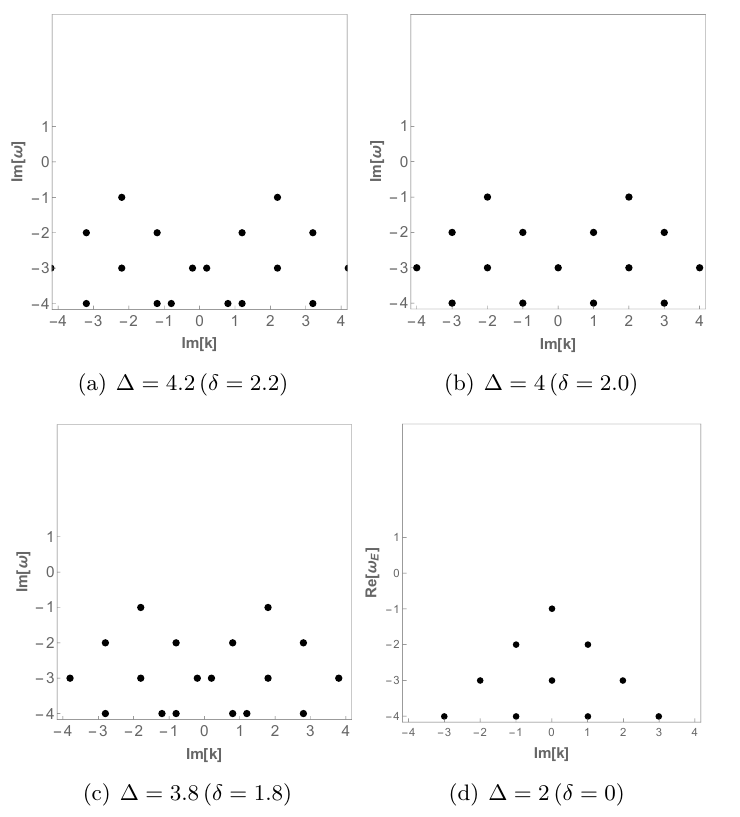
Figure 1 . The black dots represent the pole-skipping points at d = 4 (obtained from (2.14)) of a scalar field propagating in a Rindler-AdS geometry. Here δ := ∆ − d/ 2